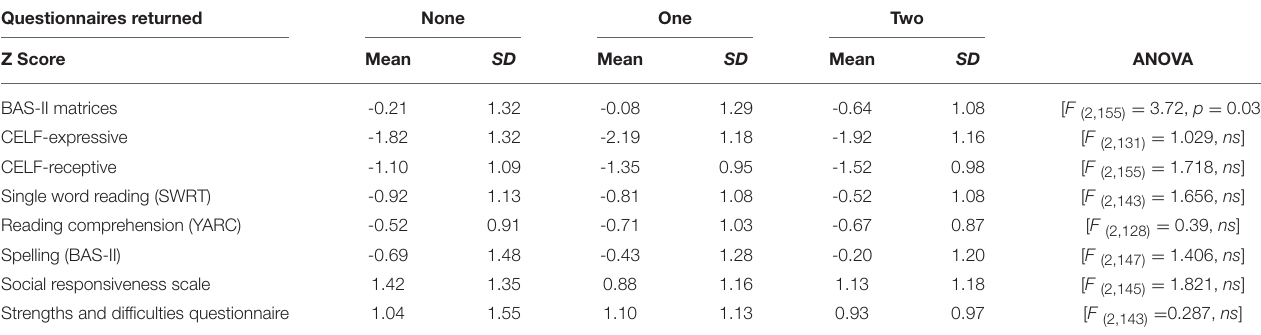
TABLE 2 | Differences between pupils for whom questionnaires were either not returned, were returned at one point only or were returned at both study